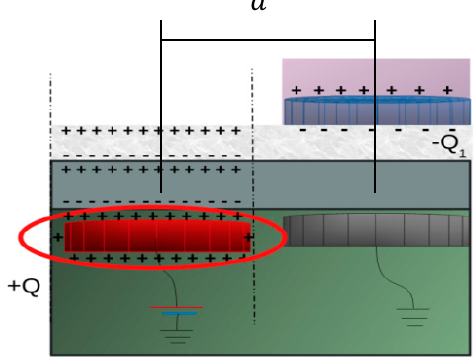
Figure 4. Charge induction due to the polarization of the dielectrics.